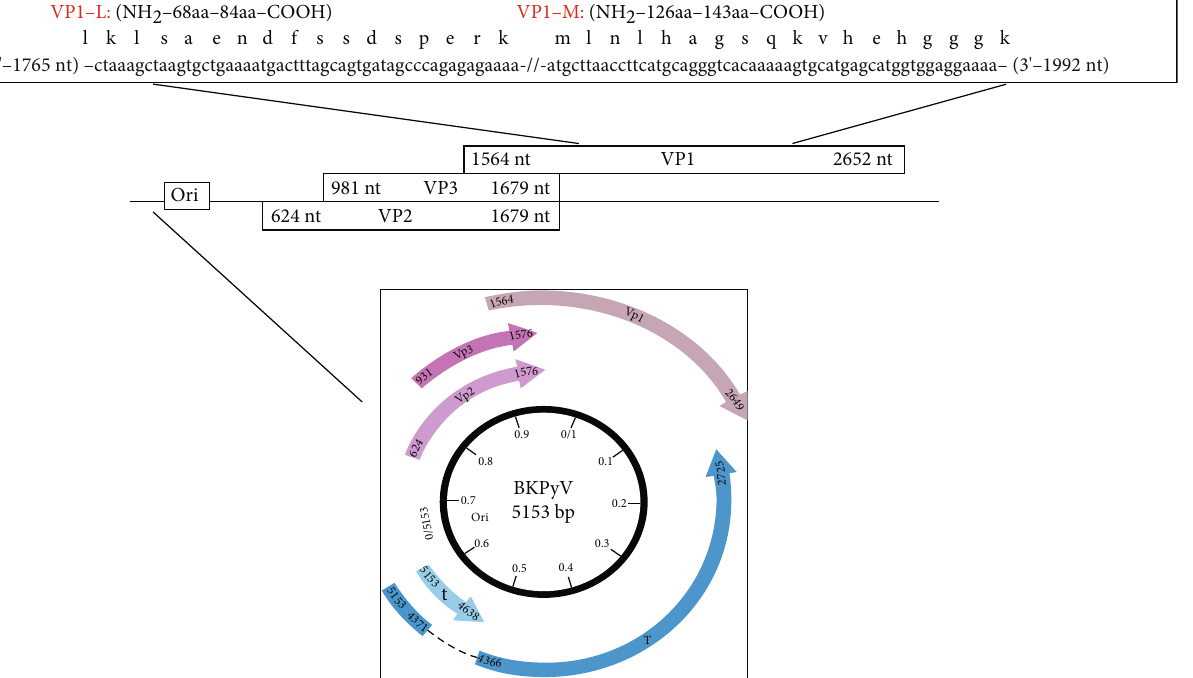
Figure 1: Mimotopes ’ sequences. BKPyV genome and the two selected peptides from the late region employed in indirect ELISA. The circle at the bottom represents the BKPyV genome, with the map unit from 0 to 100 running in a clockwise direction (inner circle, black). Ori is the origin of viral DNA replication, which is composed of 5,153 nucleotides, nt (0/5153). BKPyV nucleotide sequence is reported in http:// www.ncbi.nlm.nih.gov/genome. BKPyV early and late genes are transcribed in both anticlockwise and clockwise directions, respectively (gray arrows); numbers indicate nt. The large T antigen (T) and small t antigen (t) are encoded by the early region (T antigen, exon